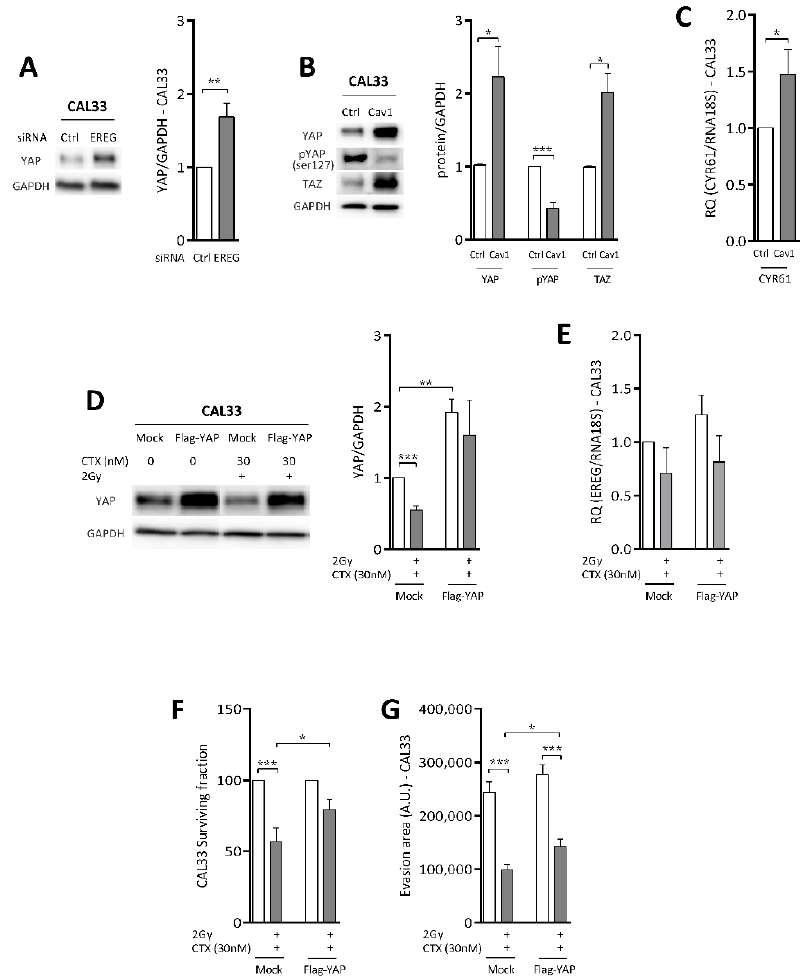
Figure 5. Repression of EREG by Cav1 is associated with the activation of the HIPPO-YAP pathway. ( A ) Expression of YAP and GAPDH was determined by Western blot (WB) in CAL33 siRNA-Ctrl and CAL33 siRNA-EREG cells. Western blots are representative of 3–5 independent experiments. YAP levels were analyzed using GAPDH as a loading control. Each bar represents the mean ( n = 3–5) ± SEM (** p < 0.01). ( B ) Expression of YAP, phospho-YAP, TAZ and GAPDH was determined by the Western blotting (WB) of lysates from the CAL33 Ctrl and CAL33 Cav1 cells. Western blots are representative of 3–5 independent experiments. YAP levels were analyzed using GAPDH as a loading control. Each bar represents the mean ( n = 3–5) ± SEM (* p < 0.05 and *** p < 0.001). ( C ) Quantitative determination of transcripts of CYR61 in CAL33 Ctrl and CAL33 Cav1 cells using RT-qPCR with RNA18S as control. Each bar represents the mean ( n = 3-5) ± SEM (* p < 0.05). ( D ) The expression of YAP and GAPDH was determined by Western blot (WB) in CAL33 Mock and CAL33 Flag-YAP cells after treatment with a combination of 2 Gy irradiation and 30 nM CTX. Western blots are representative of 3–5 independent experiments. YAP levels were analyzed using GAPDH as a loading control. Each bar represents the mean ( n = 3–5) ± SEM (** p < 0.01 and *** p < 0.001). ( E ) Quantitative determination of EREG transcripts in CAL33 Mock and CAL33 Flag-YAP after treatment with a combination of 2Gy irradiation and 30 nM CTX using RT-qPCR with RNA18S as a control. Each bar represents the mean ( n = 3–5) ± SEM. ( F ) Clonogenic survival of CAL33 Mock and CAL33 Flag-YAP cells was determined 10 days after exposure to a combination of 2 Gy irradiation and 30 nM CTX. Histograms represent the surviving fraction in each condition. Data are represented as the mean ( n = 3–5) ± SEM (* p < 0.05 and *** p < 0.001). ( G ) Analysis of collective cell migration: evasion of CAL33 Mock and CAL33 Flag-YAP cells 24 h after treatment with a combination of 2 Gy irradiation and 30 nM CTX out of the spheroids. Pictures show the evasion area and histograms represent the mean ± SEM area covered by cells evading the spheroid ( n = 3–4, * p < 0.05 and *** p < 0.001).